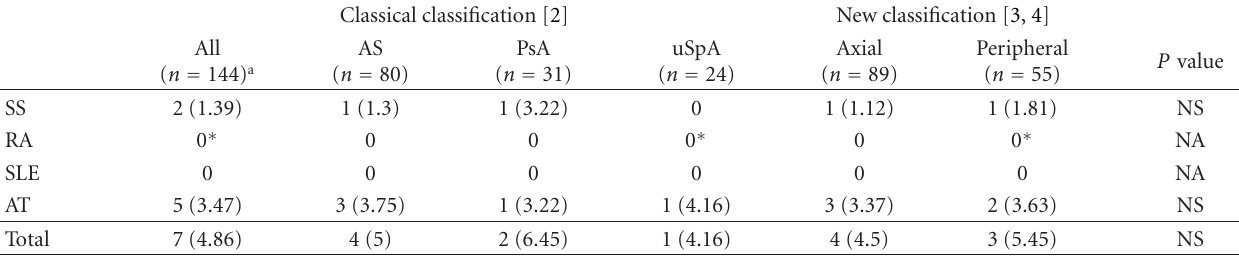
Table 5: ADs in patients with